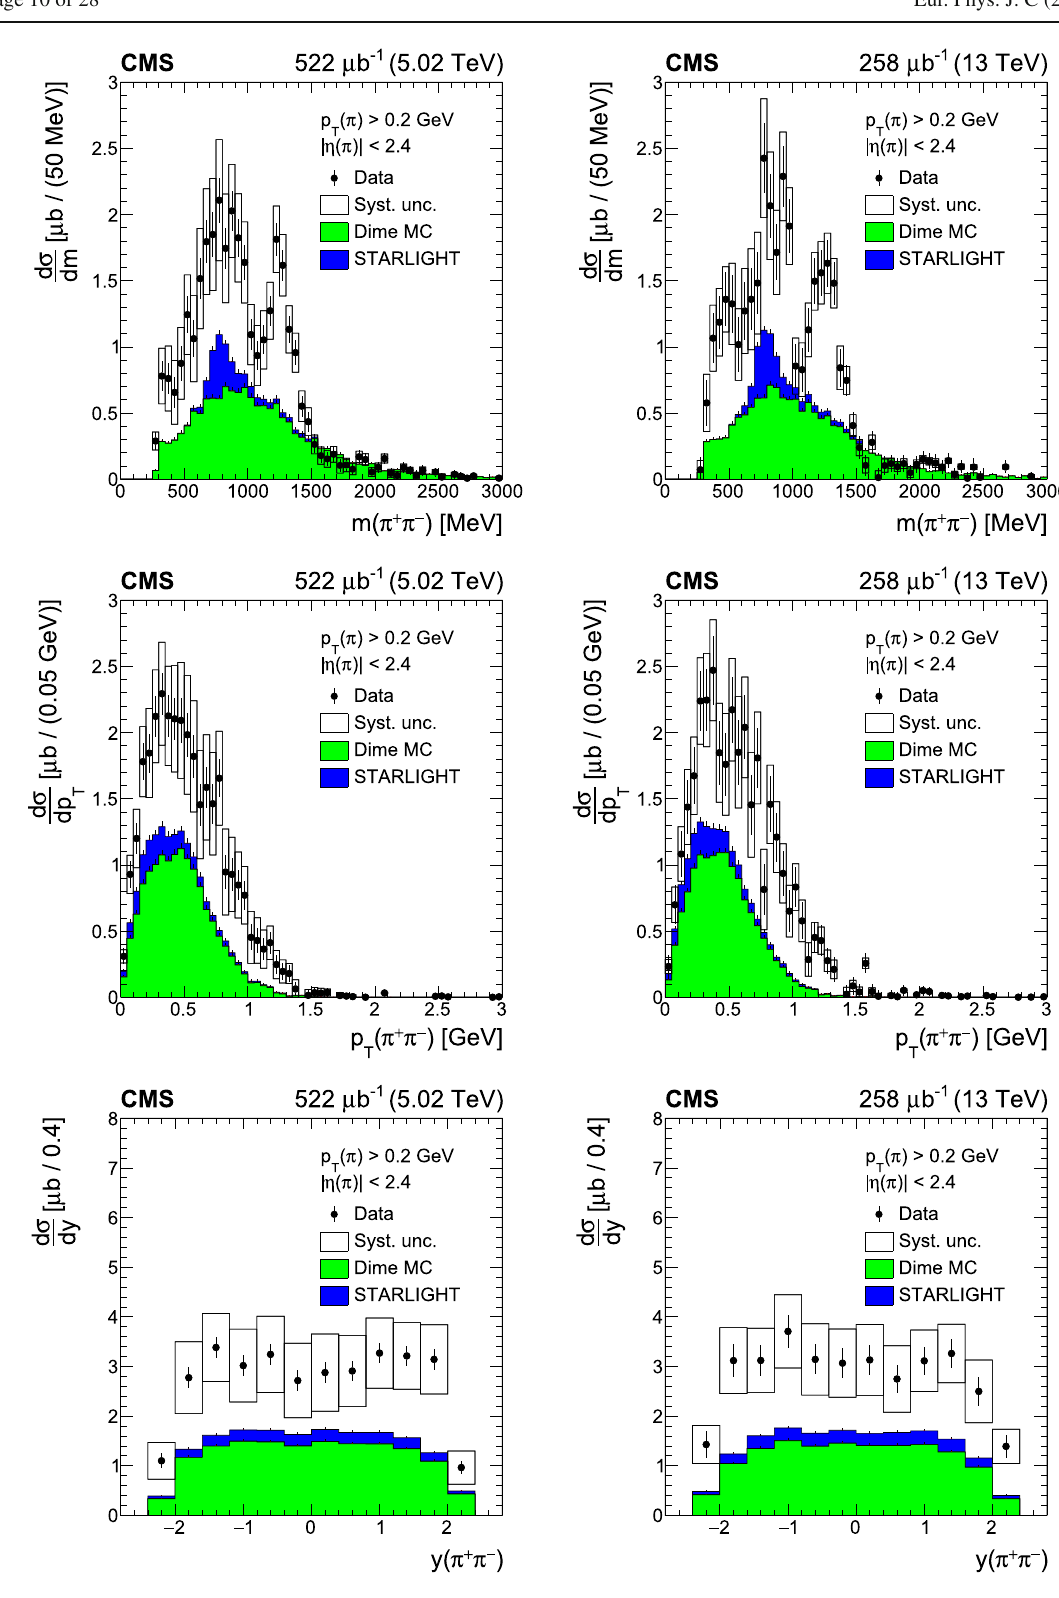
Fig. 5 Differential cross sections as functions of mass (upper row), transverse momentum (middle row), and rapidity (bottom row), compared with generator-level simulations for the 5.02 (left) and 13TeV (right) data sets. The error bars correspond to statistical, whereas the open boxes to systematic